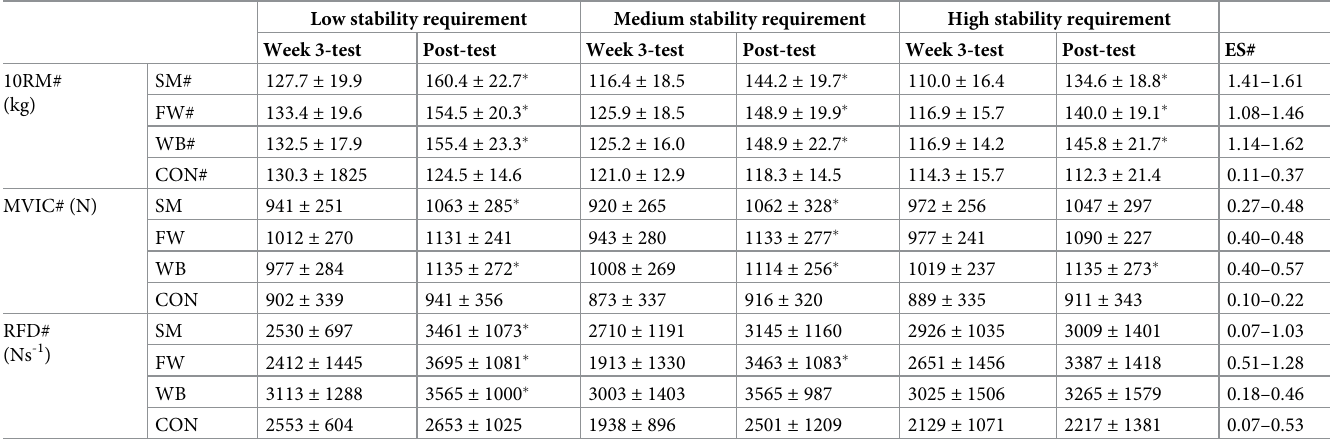
Table 4. Changes in 10RM, MVIC and RFD with low, medium or high stability requirements for the groups between week 3-test and